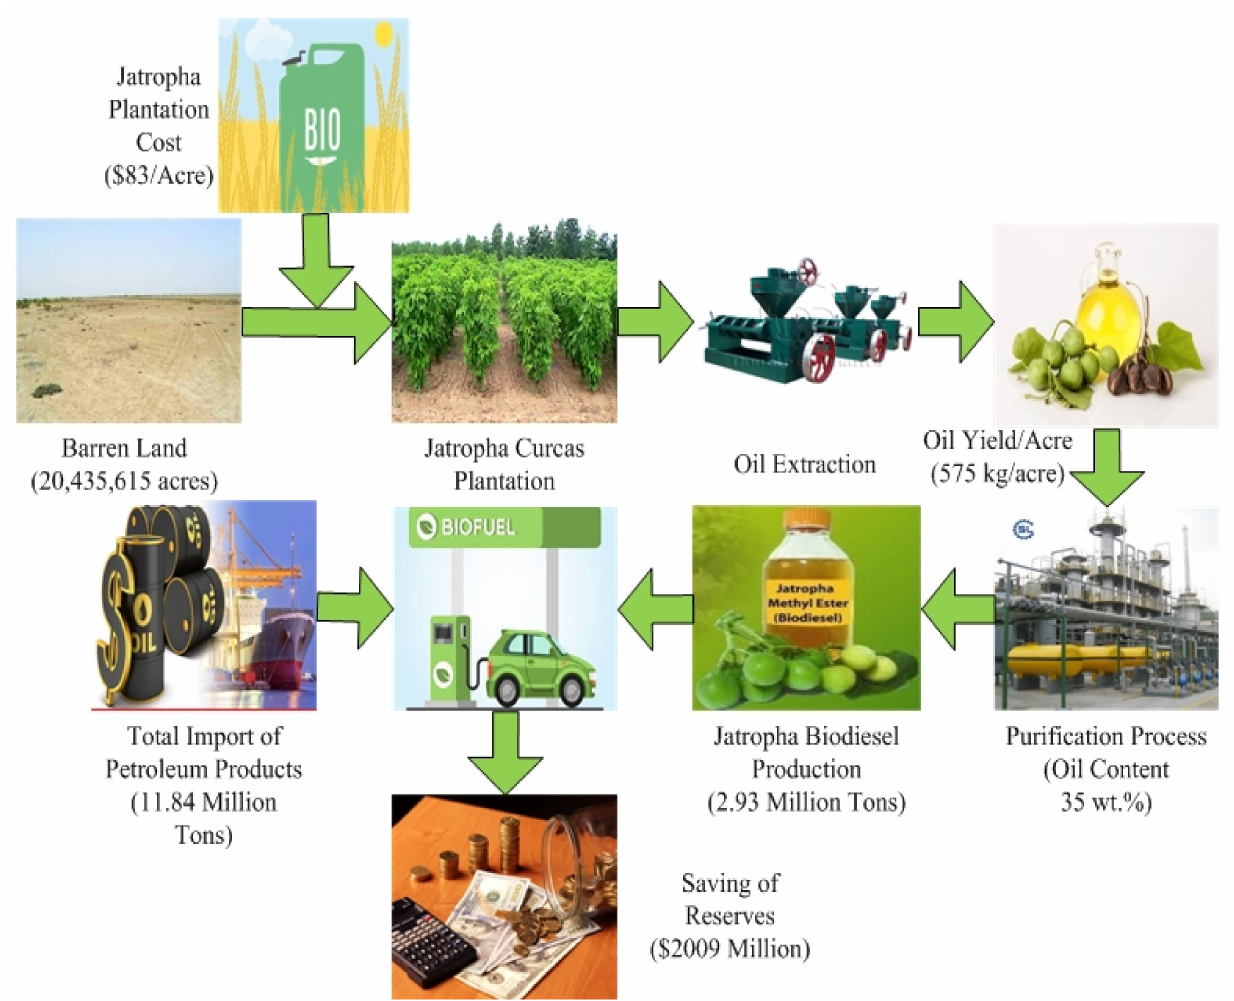
Figure 12. The potential of Jatropha biodiesel in